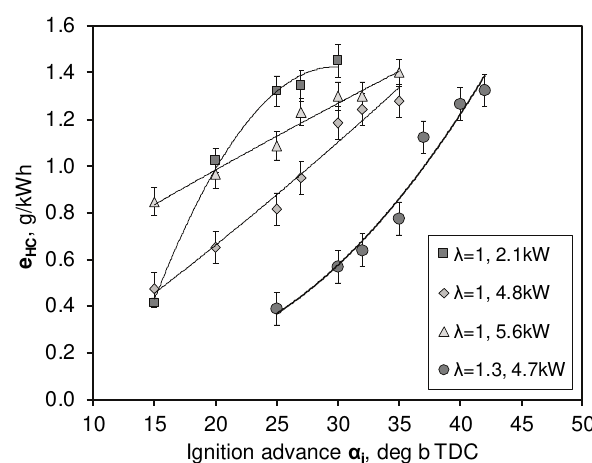
Fig. 6. Specific emission of HC vs ignition timing, throttle position and mixture composition